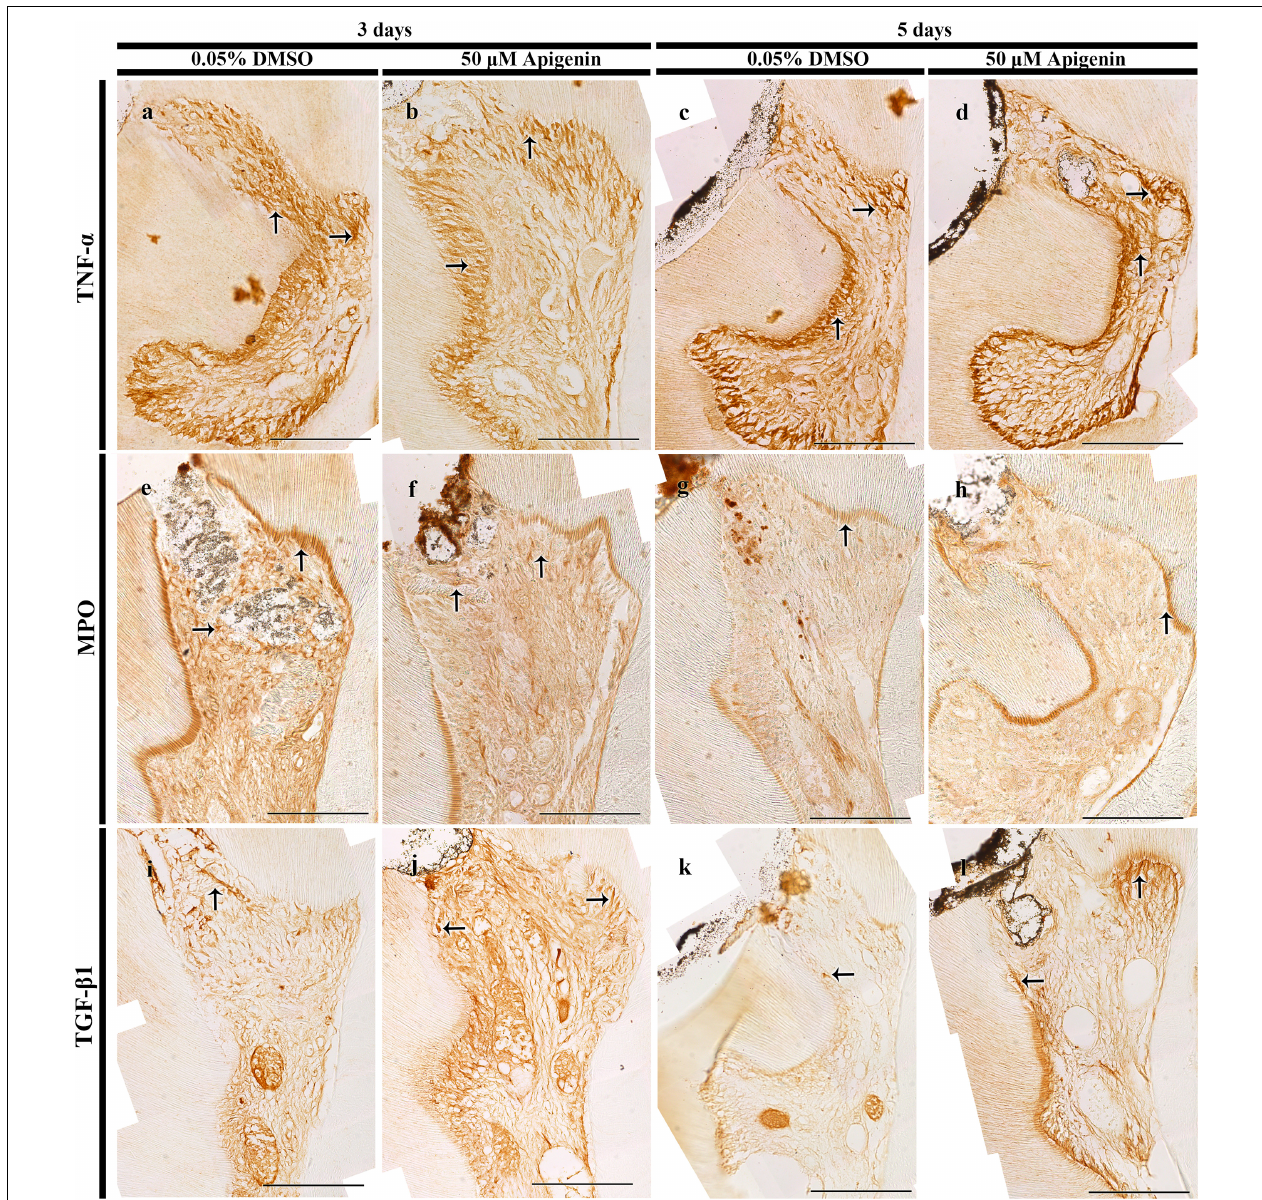
FIGURE 3 | Immunostainings of tumor necrosis factor (TNF)- α , myeloperoxidase (MPO), and transforming growth factor (TGF)- β 1. The localization of TNF- α is decreased in both 3- and 5-day apigenin-treated specimens (arrows) when compared to control (a–d) . On day 3, the localization of MPO is decreased in the apigenin-treated specimens; however, the immunostaining of MPO is almost similar in both DMSO-control and apigenin-treated specimens (arrows) on day 5 (e–h) . In contrast, increased immunostaining of TGF- β 1 is observed in both 3- and 5-day apigenin-treated specimens (arrows) when compared to control (i–l) . Scale bars: 50 µ m (a–l)